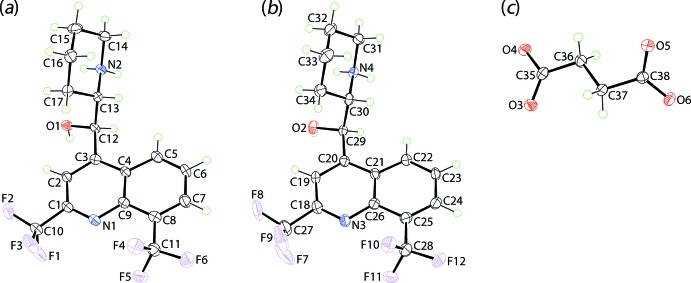
The mol­ecular structures of the ionic components of the asymmetric unit of (I) showing the atom-labelling scheme and displacement ellipsoids at the 50% probability level: (a) the N1-containing cation, (b) the N3-cation and (c) the butane­dioate dianion.